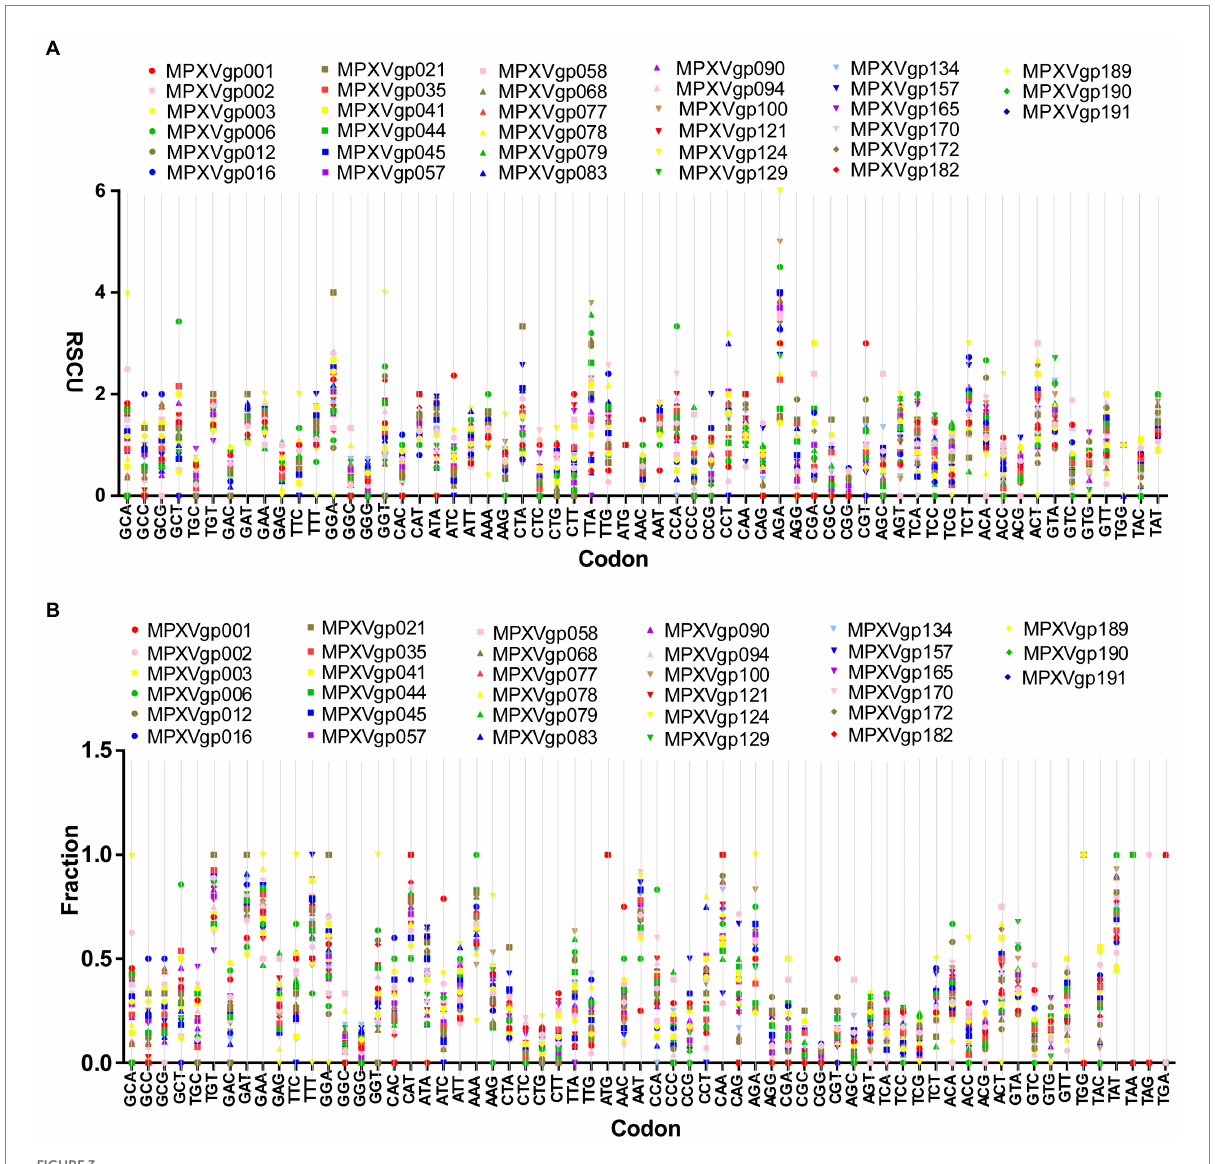
FIGURE 3 Relative Synonymous Codon Usage (RSCU) and Synonymous Codon Usage fraction. (A) Relative Synonymous Codon Usage (RSCU) for genes that displayed mutations in the Clade IIb-B.1 lineages of viruses compared with NC_063383.1/ MT903340.1. More than 1,000 sequences from different lineages in Clade IIb were used, and details are provided in Supplementary Data S1. The RSCU values of each gene are given in Supplementary Data S2. (B) Synonymous Codon Usage fraction for genes that displayed mutations in the Clade IIb-B.1 lineages of viruses compared with NC_063383.1/ MT903340.1. More than 1,000 sequences from different lineages in Clade IIb were used, and details are provided in Supplementary Data S1. The SCUF values of each gene are given in Supplementary Data